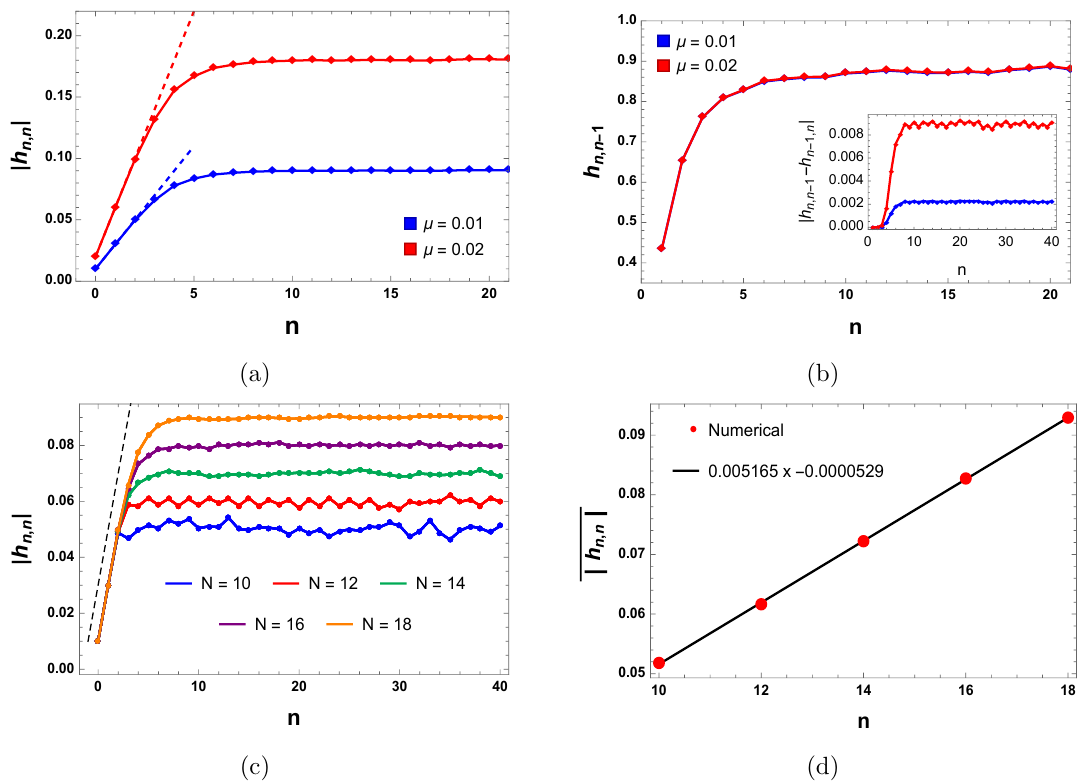
Figure 3 . Behavior of the (a) primary diagonal and (b) off-diagonal elements respectively, for two different dissipation µ = 0 . 01 and µ = 0 . 02 . The dotted lines in (a) are the fitted straight lines (5.7). The inset in (b) shows the difference | h n,n − 1 − h n − 1 ,n | grows with the dissipation. (c) The behavior of the diagonal elements (magnitude) for different system sizes. The black dotted line denotes the straight line (5.7) (with an offset introduced for visualization). (d) The saturation value (averaged for n = 10 to n = 40 ) of the diagonal elements for different system sizes. In all cases, our system size is N = 18 (single realization) and we choose q = 4 , J = 1 , and the fixed dissipation µ = 0 . 01 in (c) and